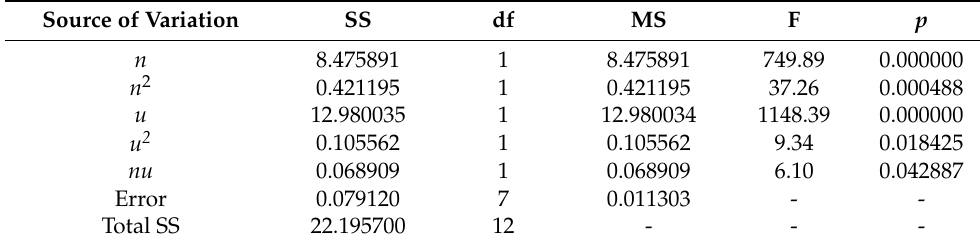
Table 4. Model of polymer blend pressure P —ANOVA table, R 2 = 0.99; R adj2 = 0.99. Source of Variation